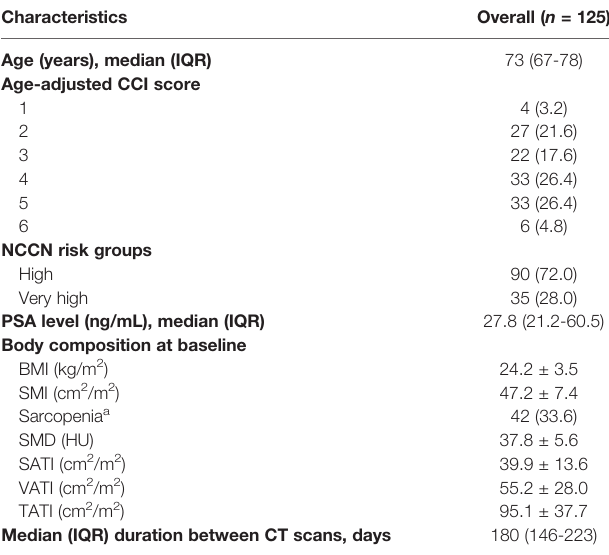
TABLE 1 | Patient and tumor characteristics.